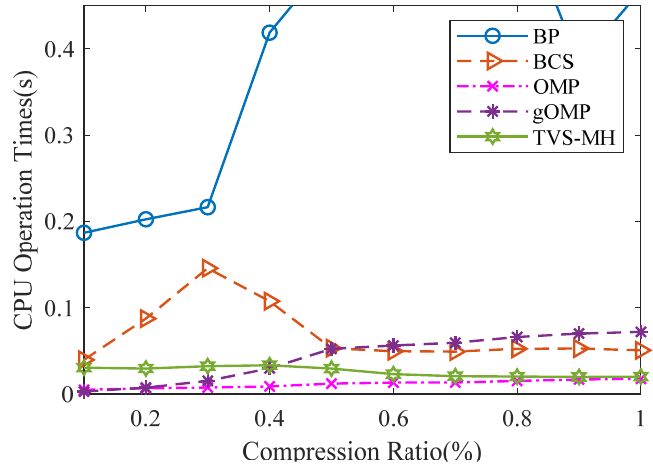
Figure 12. The relation between CPU operation time and compression ratio for a same sparse gas signal using different reconstruction algorithms. Table 4. The testing environment.